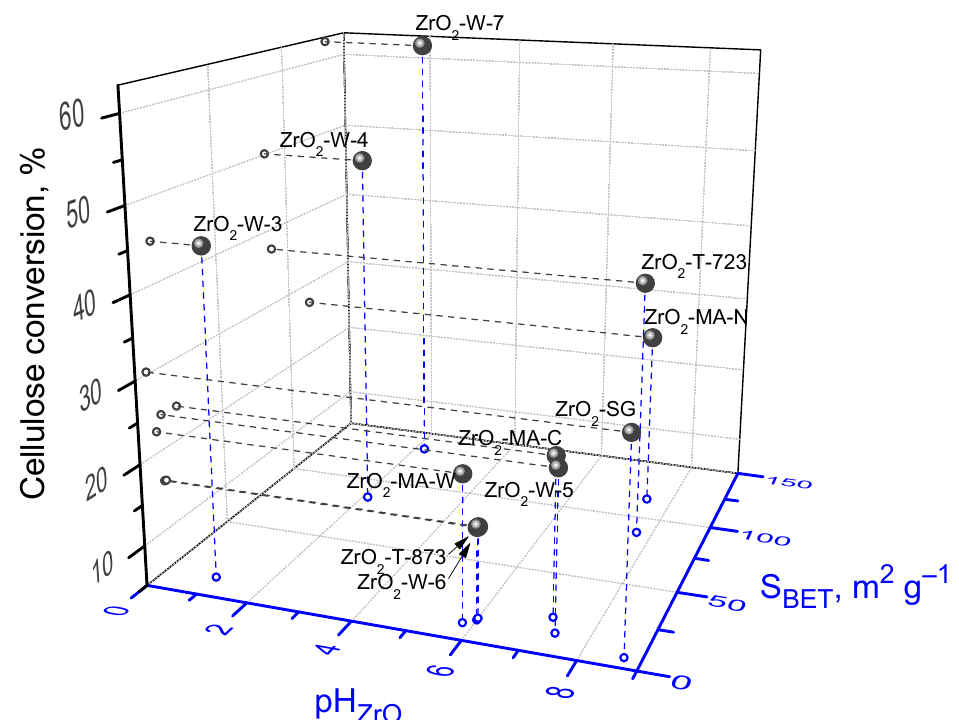
Figure 1. Dependence of the cellulose conversion on pH ZrO2 and specific surface area of catalysts. Reaction conditions: initial concentrations of cellulose and catalyst 10 g L − 1 , reaction volume 45 mL, 453 K, P Ar 1 MPa, 1000 rpm, reaction time 7 h.